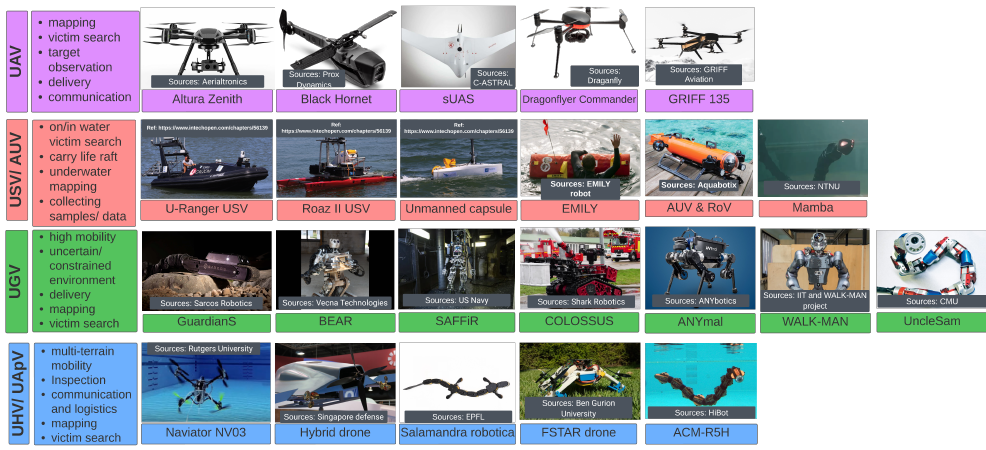
Figure 1. Examples and categories of various robots that could be used in SAR applications